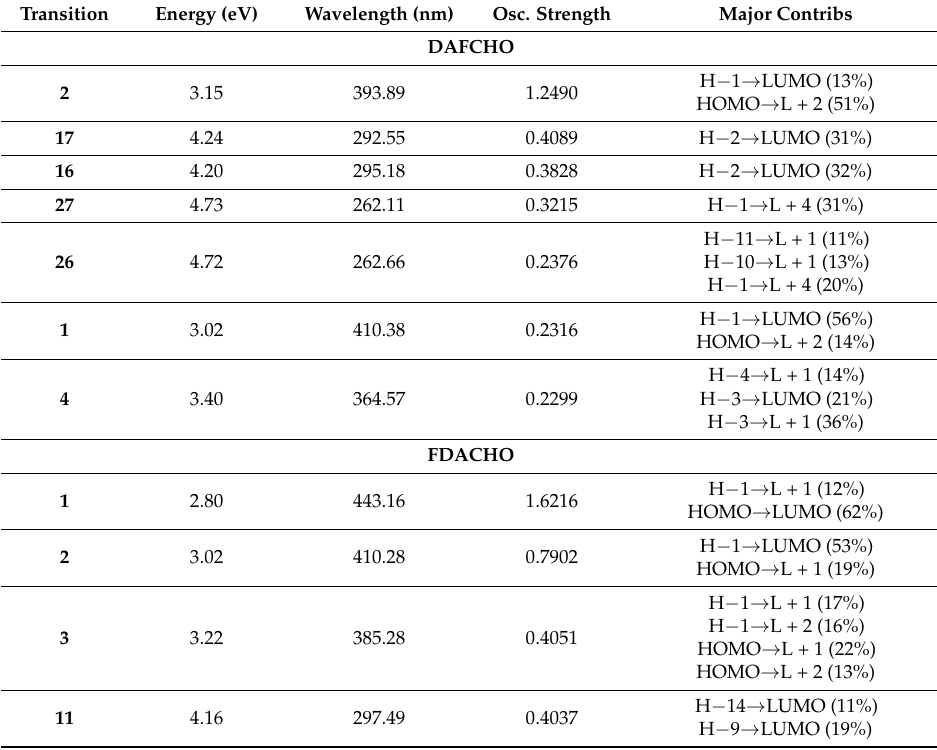
Table 3. Main electronic excitations of molecules DAFCHO and FDACHO, listing only their major molecular orbital contributions (greater than